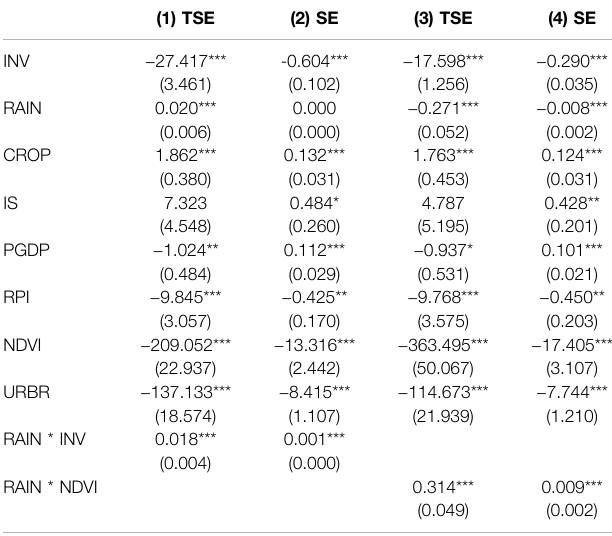
TABLE 7 | The estimation results of model speci fi ed in Eq. 12